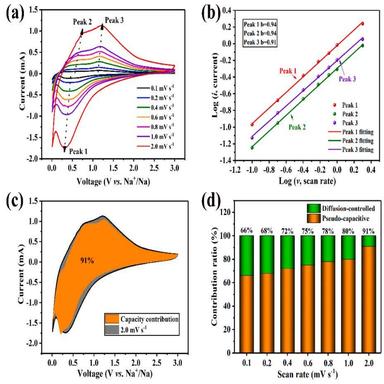
Kinetic investigation of SnS@FeS/C anode in SIBs. (a) CV curves at different scan rates, (b) the b-values of anodic peaks and cathodic peaks, (c) capacitive contribution at 1.0 mV s − 1 and (d) contribution ratio of pseudocapacitive-controlled and diffusion-controlled at different scan rates.